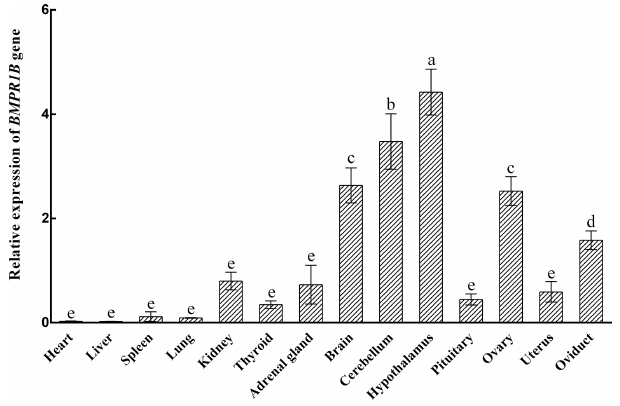
Figure 1. Relative expression of the BMPR1B gene in various tissue types in small-tail Han sheep in the follicular phase. Different letters represent a significant difference ( P < 0 .